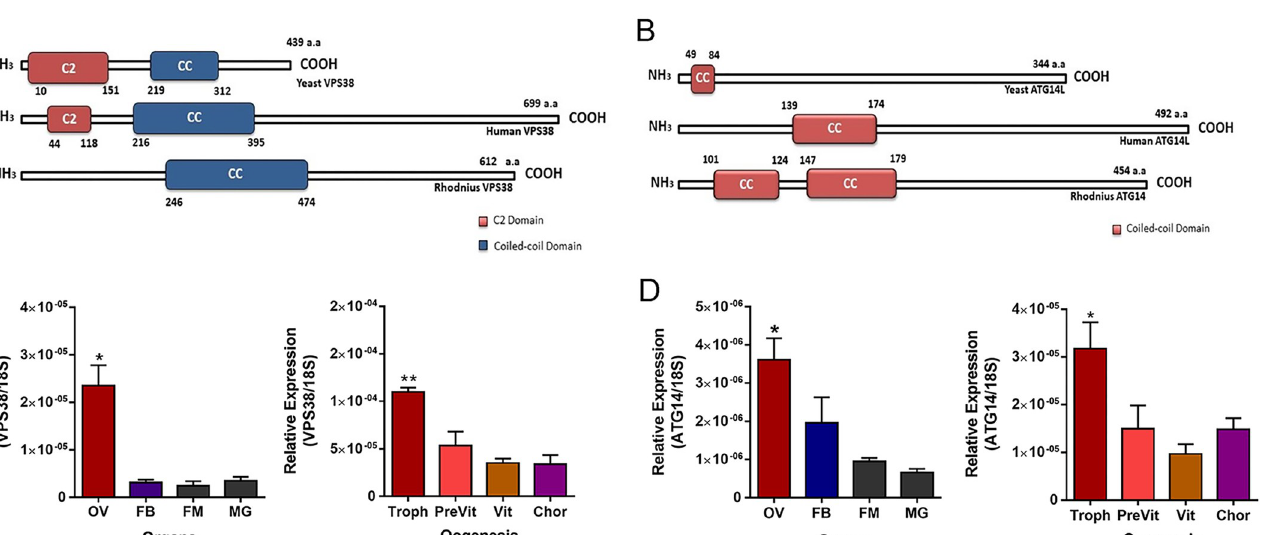
PLOS NeglectedTropical Diseases | https://doi.org/10.1371/journal.pntd.0009760 September 7,